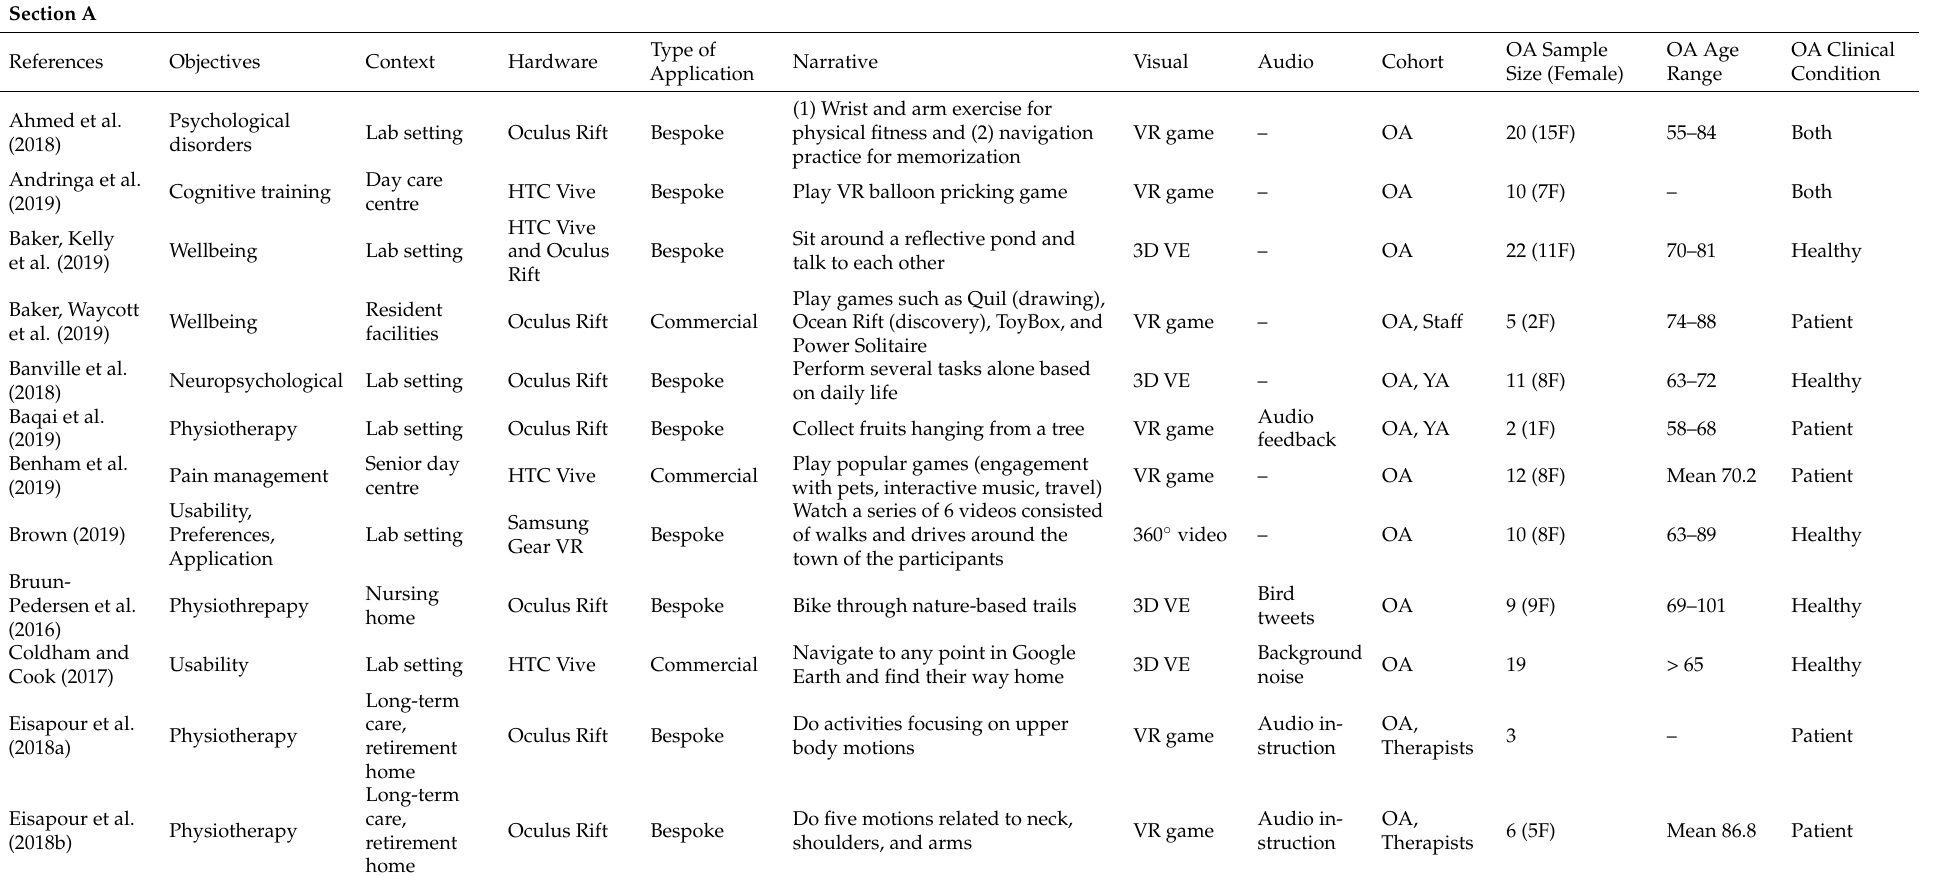
Table 1. Summary of 36 reviewed papers (OA: older adults, YA: young adults, en dash "–": Not specified). The papers were arranged alphabetically by the first author’s surname and divided into three sections: A, B, and